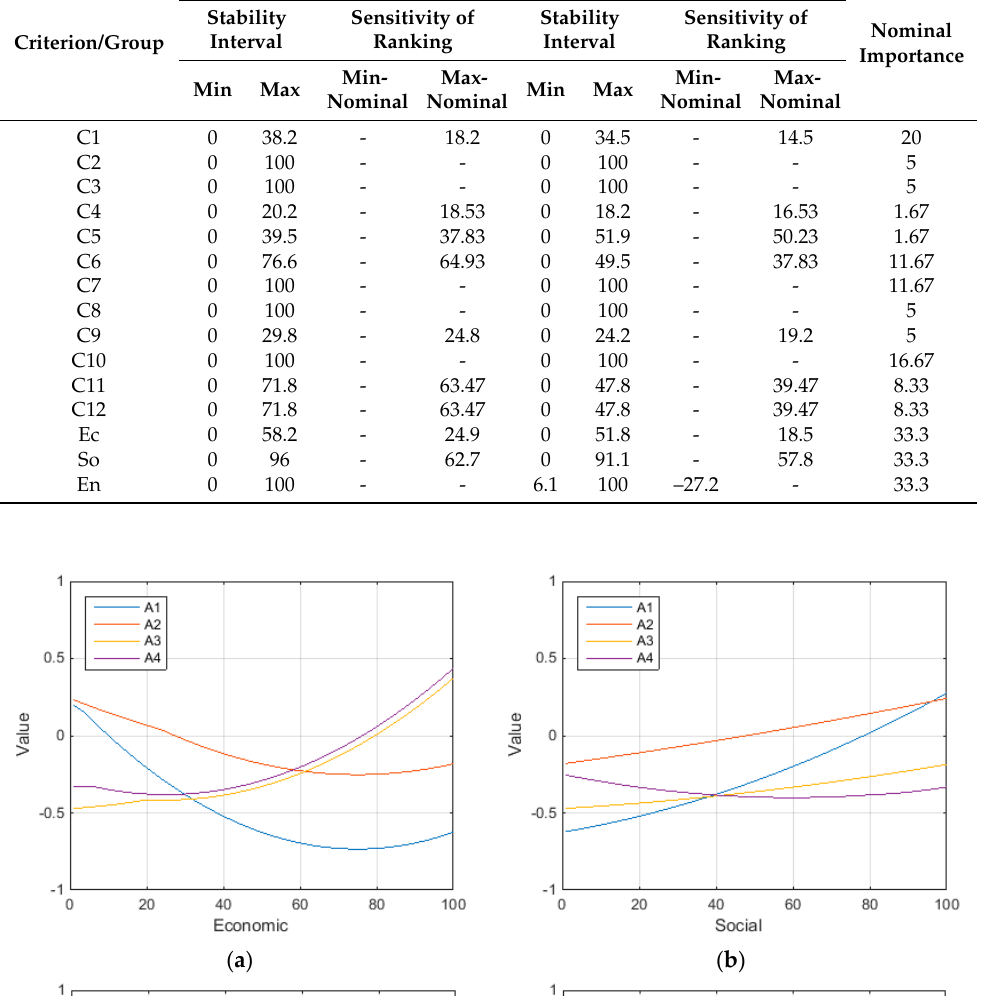
Table 8. Stability intervals of best variants in rankings for values of criteria and groups.